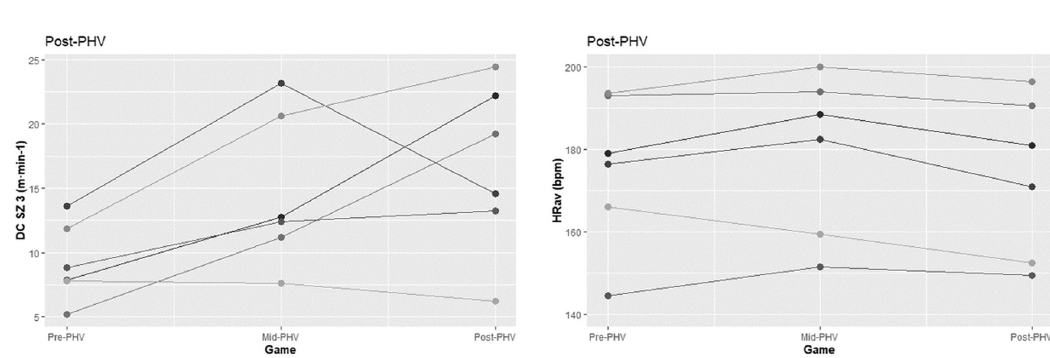
Fig 4. Individual graphical representation of significant differences in physical and tactical performance between game formats amongst Post-PHV athletes.